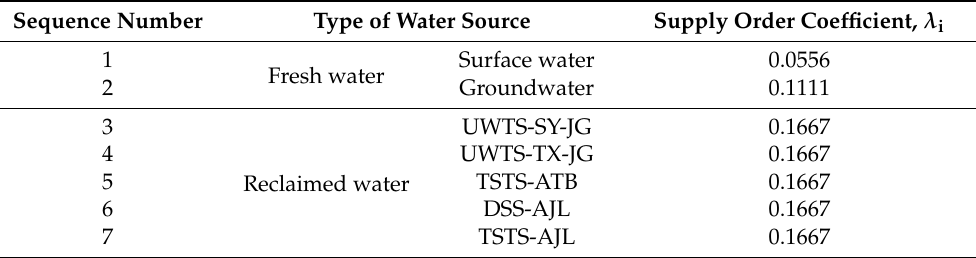
Table 8. Supply order coefficients from different water sources. The meaning of the abbreviations is shown in Table 1.